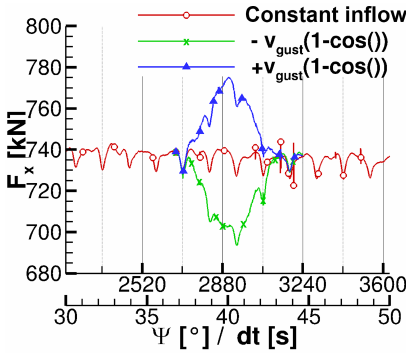
Figure 3. Rotor thrust F x during the gust.